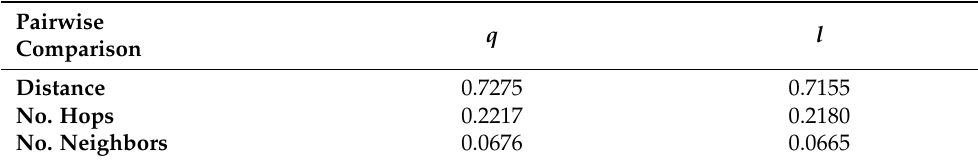
Table 8. Non-fuzzy ( q i ) and normalized ( l i ) weights (from 14,15).